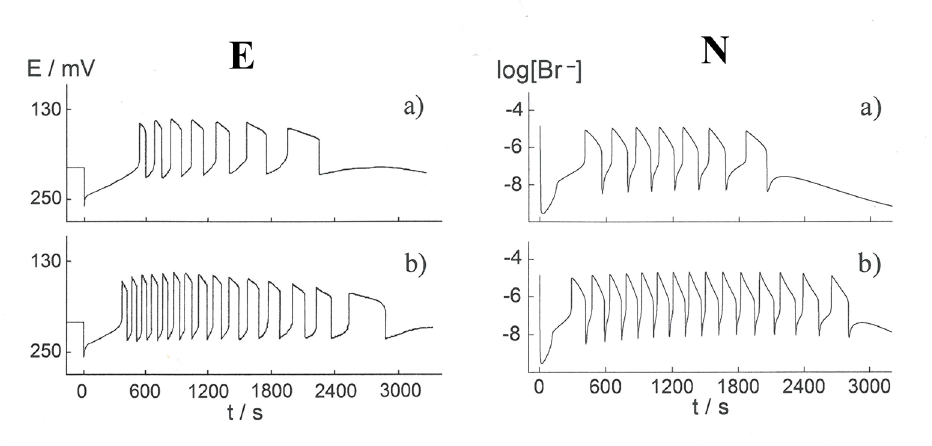
Figure 1: The oscillograms obtained experimentally E, and by the numerical simulation N, at T = 30°C, for [CH a) 1.60 × 10 –2 and b) 2.20 × 10 –2 . Experimental results E, present the potentiometric traces of the bromide ion-sensitive electrode. Calculated results N, present the time dependence of log[Br − ] obtained by the numerical simulation according the kinetic scheme given in Table 1 [14].